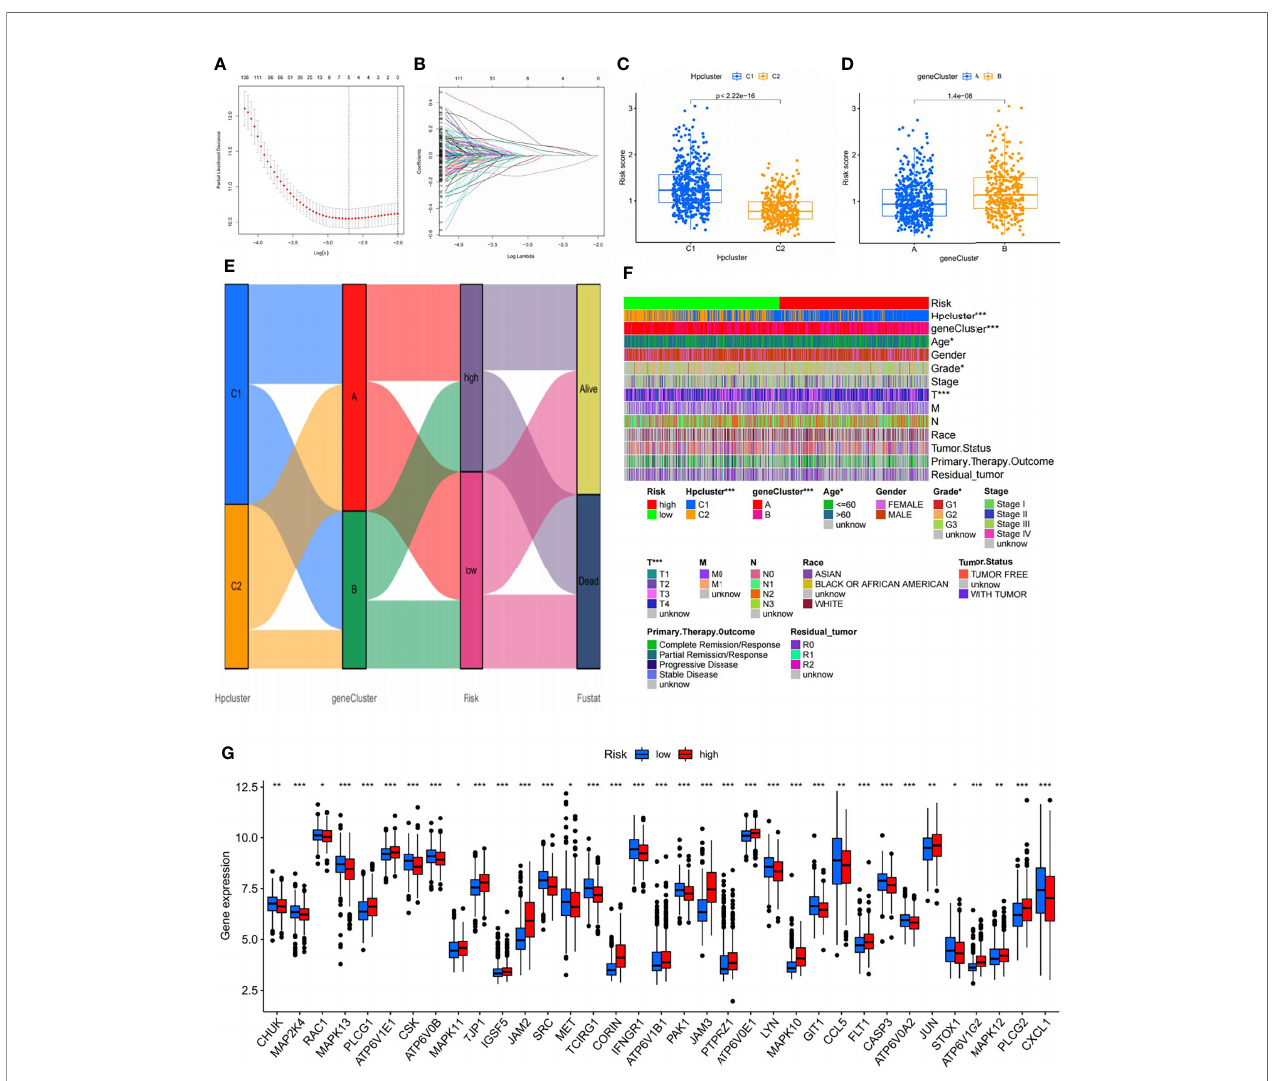
FIGURE 6 | Selection of optimal prognostic signatures and constructure of risk signature in the training set. (A) Multivariate cox regression analysis for prognostic genes. (B) LASSO regression analysis for prognostic genes. (C) Differences in risk score among distinct HPclusters. (D) Differences in risk score among distinct gene clusters. (E) Alluvial diagram showing the changes of HPclusters, geneClusters, risk signature, and future status. (F) Heat map regarding the correlation between the risk signature, molecular, genetic classi fi cation, prognosis, and clinical features. (G) Differences in the expression of 39 DEGs among the low-risk group and high-risk groups. The blue bars and the red bars represent the groups with low and high m7Gscores, respectively. ns, no signi fi cance, p ≥ 0.05; *, p<0.05; **, p<0.01; ***,